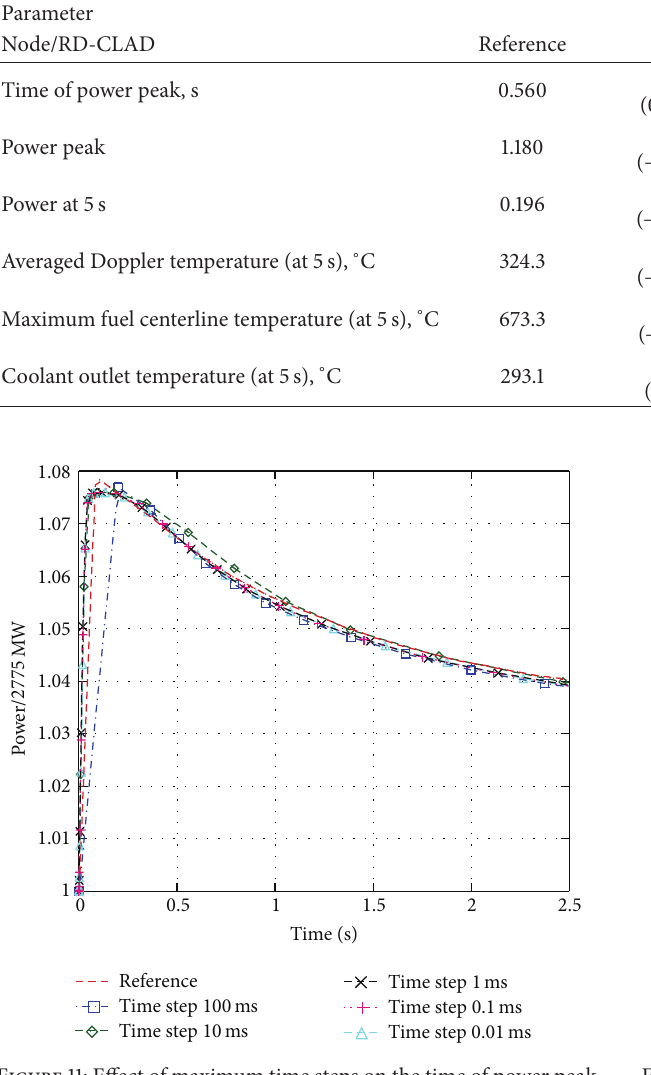
Figure 11: Effect of maximum time steps on the time of power peak for case A2.